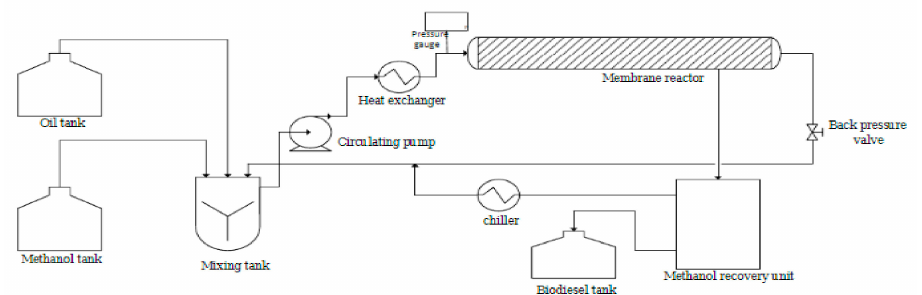
Figure 5. A membrane reactor for biodiesel synthesis is depicted schematically in this diagram [18]. Following that, the reactants were fed into the reaction medium. Two pressure gauges were used to measure the pressure inside the membrane, which was maintained at a constant 100 Kpa. The beaker was used to receive the permeates comprising of biodiesel and methanol. The circulating pump and heat exchanger were turned off at the end of every cycle. Following that, the catalysts were removed, and the reactor was purged with methanol for half an hour before being completely emptied. The following equation (1) was used to compute the biodiesel production in this study: